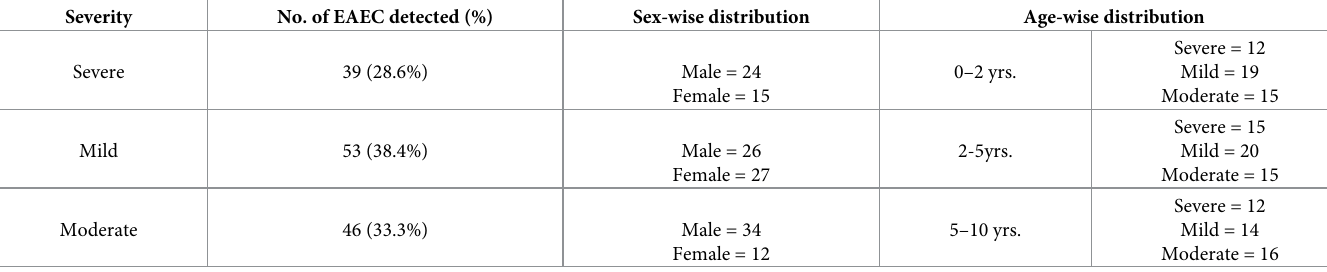
Table 6. The severity of EAEC infected children based on the number, age, and gender.